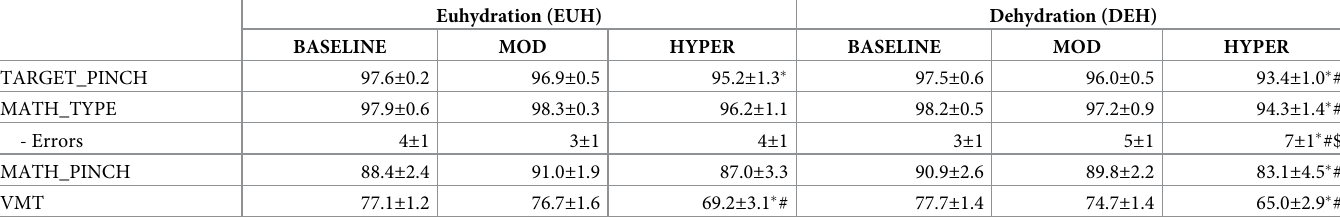
Table 2. Mean performance scores in the four different tasks during euhydration and dehydration with levels of